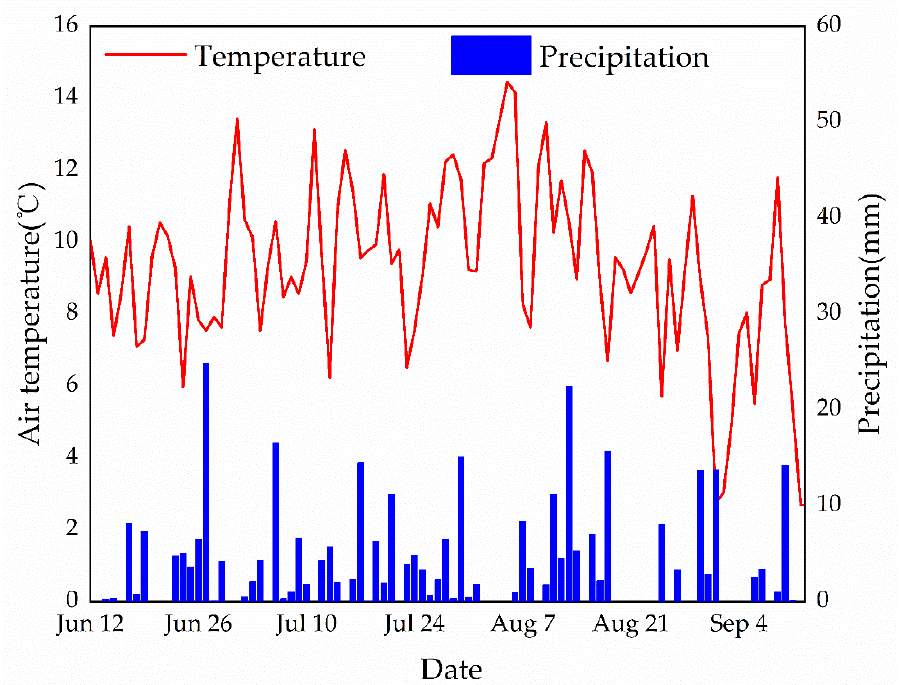
Figure 4. The air temperature and precipitation in the shrub site during the experiments’ period in 2012.